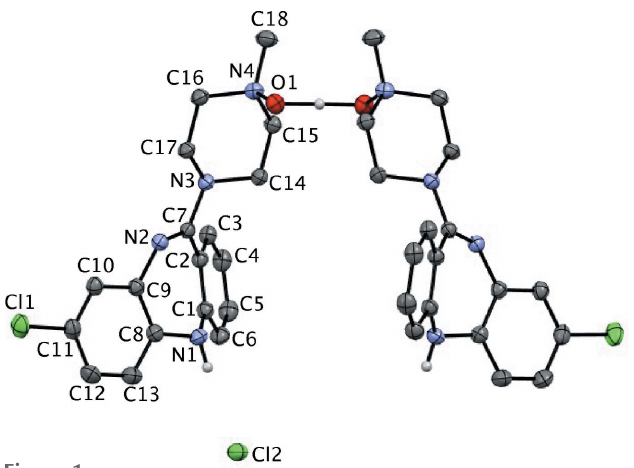
Figure 1 The molecular structure of (CNO) 2 (cid:2) HCl showing 50% displacement ellipsoids with C-bound H atoms omitted for clarity. The unlabelled atoms are generated by the symmetry operation (cid:4) x , 1 (cid:4) y , z .